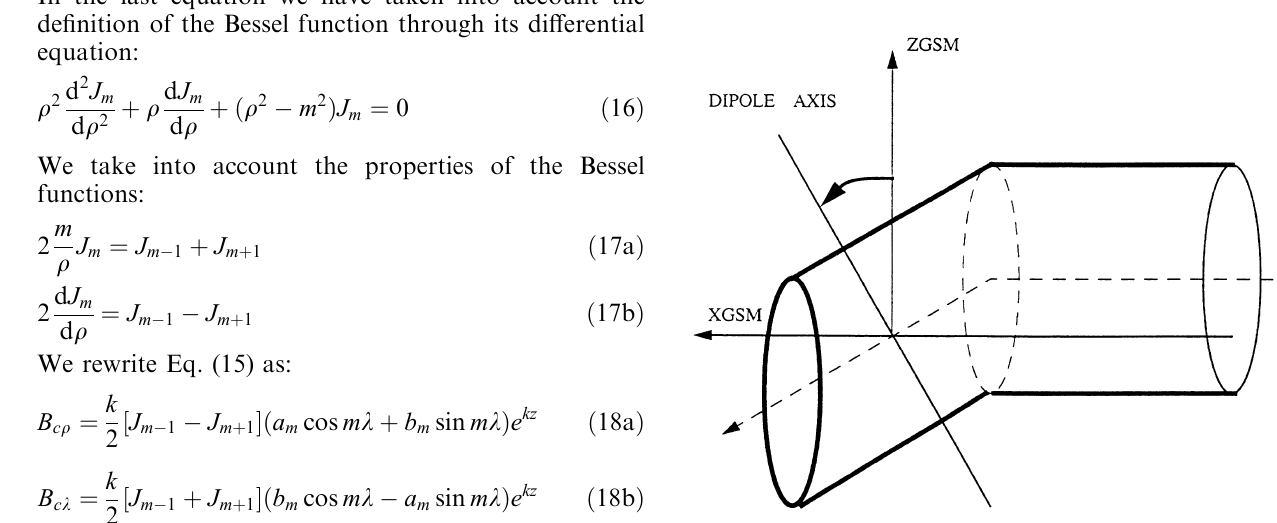
Fig. 1. The return currents can be represented by two poloidal vector fields expressed in a cylindrical coordinate system. These cylindric functions join at the edge of the neutral sheet. One cylinder tilts while the other moves upward. The characteristic radius of the Bessel functions is 30